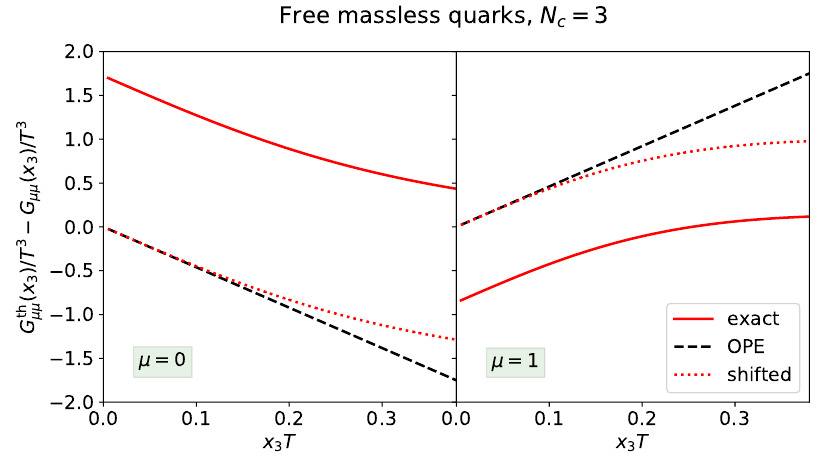
( x 3 ) − G µµ ( x 3 ) µµ